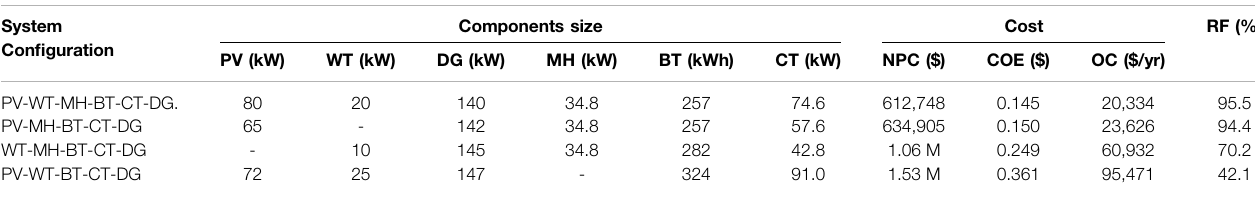
TABLE 9 | Performance of optimized results of HRES for off Grid